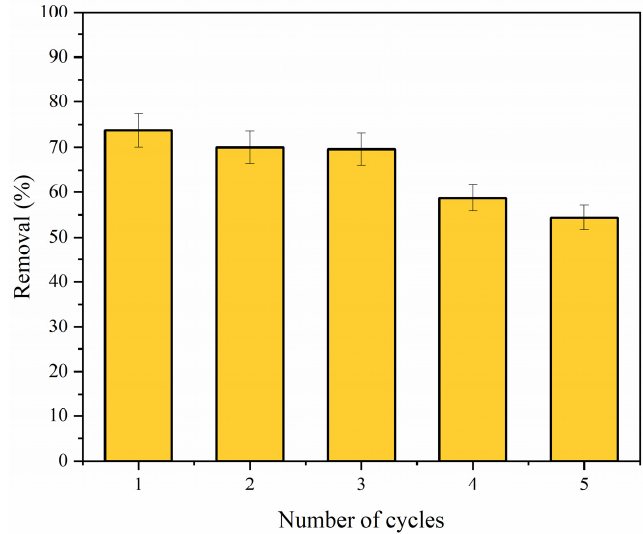
Figure 14. CS · Fe 3 O 4 performance after several adsorption Figure 14. CS·Fe 3 O 4 performance after several adsorption cycles .